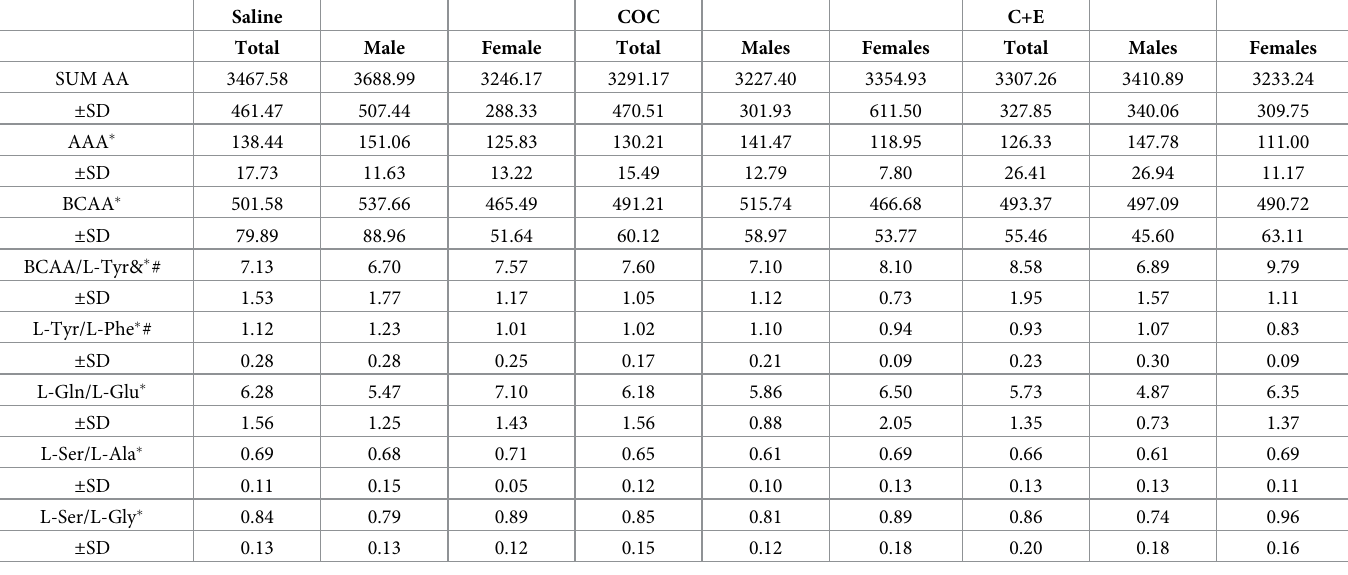
Table 2. Effect of self-administration of cocaine and C+E on plasma amino acid molar